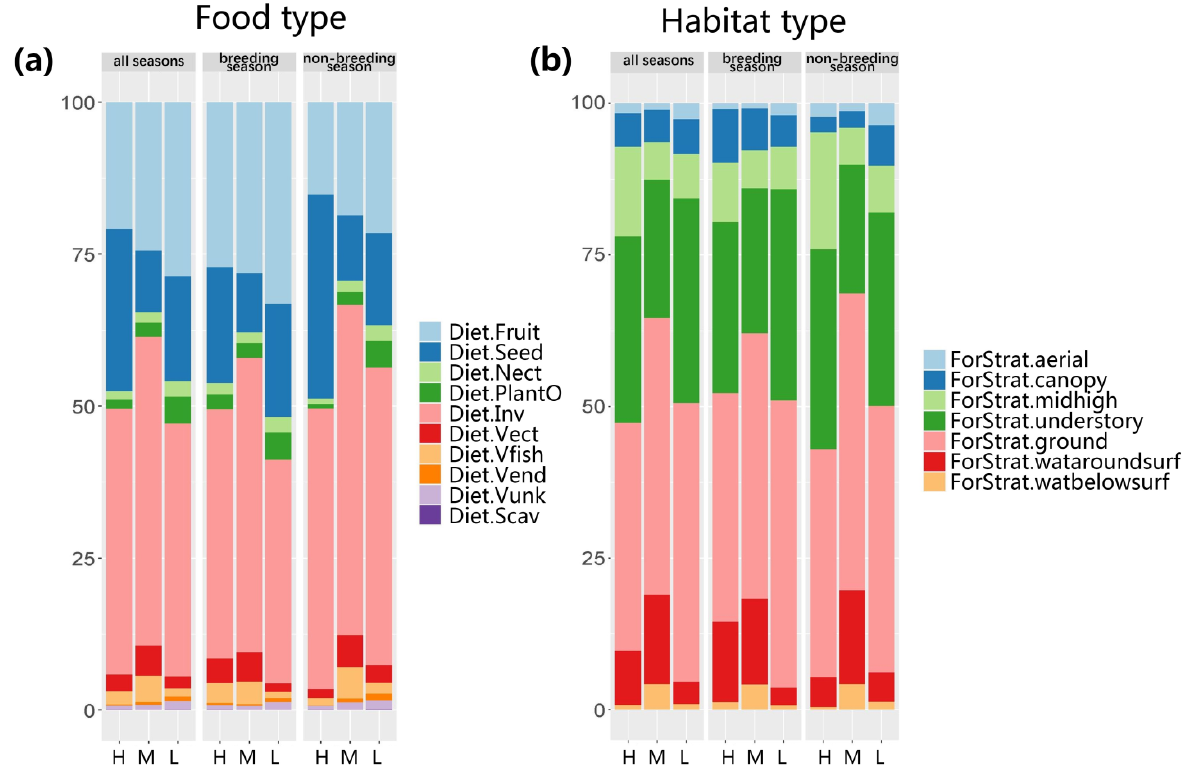
Figure 3. Relative abundance of different avian groups in the annual cycle, breeding season, and non-breeding season at high-, medium-, and low-human disturbance rivers (H — high-human dis- turbance rivers; M — medium-human disturbance rivers; L — low-human disturbance rivers). ( a ) Birds were grouped by their diet (Diet.Fruit — fruit; Diet.Seed — seeds; Diet.Nect — nectar; Diet.PlantO — other plant material; Diet.Inv – invertebrate; Diet.Vect — reptiles, amphibians; Diet.Vfish — fish; Diet.Vend — mammals, birds; Diet.Vunk — vertebrates (general or unknown); Diet.Scav – scavenge, garbage, offal, carcasses, trawlers, carrion). ( b ) Percentage time spent on the seven categories of the stratum (ForStrat.aerial — canopy stratum; ForStrat.canopy — canopy stra- tum; ForStrat.midhigh — mid-high stratum; ForStrat.understory — understory stratum; For- Strat.ground — ground stratum; ForStrat.wataroundsurf — around water surface; ForStrat.watbe- lowsurf — below the water surface).